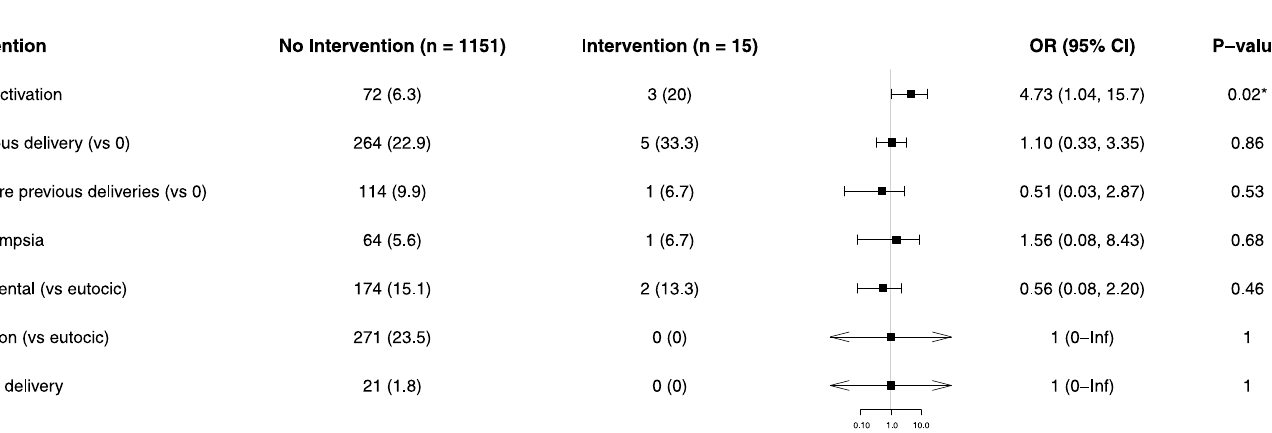
Fig 3. Forest plot of multivariate logistic analysis of the influence of MEWS activation, patient comorbidity and delivery on emergency surgery within two hours. We present the results as an odds ratio with a 95% confidence interval. Results less than 1, left of the y-axis, imply risk reduction. We accepted p < 0.05 as significant.